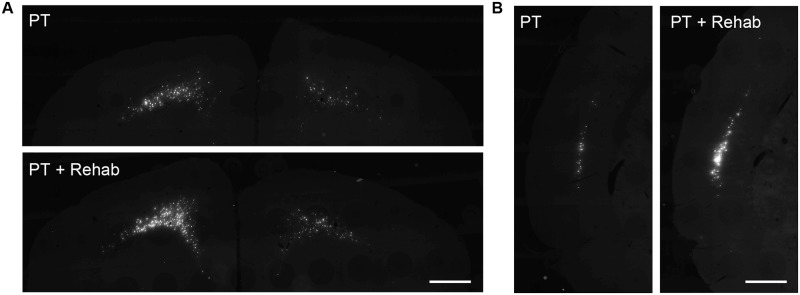
Distribution of Fast blue-positive neurons in the cerebral cortex.Representative pictures of Fast blue labeled brain sections in the rostral forelimb area (A) and secondary sensory area (B) of the PT rats and the PT + Rehab rats. The ipsilesional hemisphere is located on the left side. Scale bars = 1 mm.